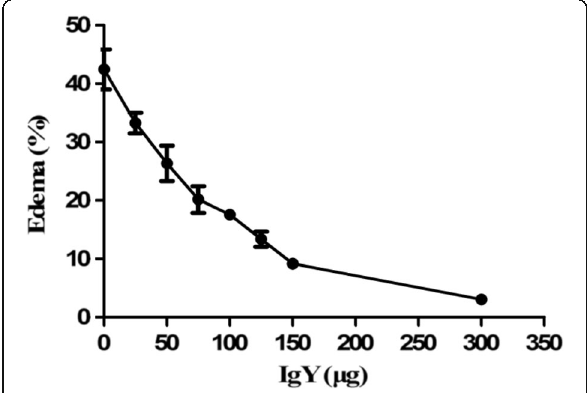
Fig 7 Neutralization of edema-forming activity of D. acutus venom by IgY (mean ± SD, n = 4). Mixtures containing a constant amount of venom and various dilutions of IgY were incubated at 37 °C for 30 min. Afterwards, aliquots of the mixtures (20 μ L containing three MED of venom) were injected into the right footpad of mice, whereas the left foot pad received 20 μ L of physiological saline. The weight of both feet was estimated 3 h after injection with an electronic scale and edema was expressed as the percentage increment in weight of the right footpad when compared to the left one